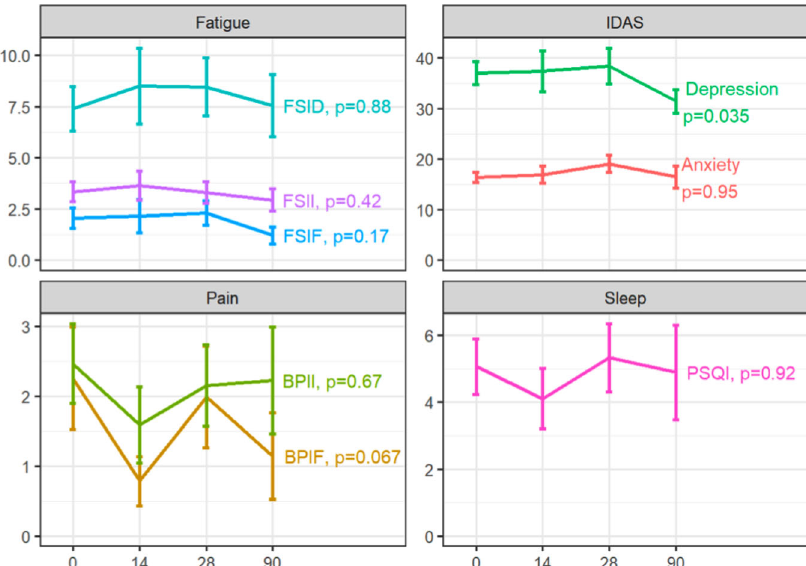
Fig. 2 Patient-reported outcome (PRO) mean changes over time. BL baseline, BPIF Brief Pain Inventory Fatigue, BPII Brief Pain Inventory Intensity, FSID Fatigue Symptom Inventory Duration, FSIF Fatigue Symptom Inventory Interference, FSII Fatigue Symptom Inventory Intensity, IDAS Inventory of Depression and Anxiety Symptoms, PSQI Pittsburgh Sleep Quality Index. Pain, fatigue, depression, and anxiety were analyzed via a mixed effect longitudinal model fi tted for all eligible patients ( n = 15) and sleep was analyzed via a mixed effect logistic regression model ( p = 0.035 for depression; remaining variables did not demonstrate signi fi cant differences over time). Error bars indicate standard error of the mean.